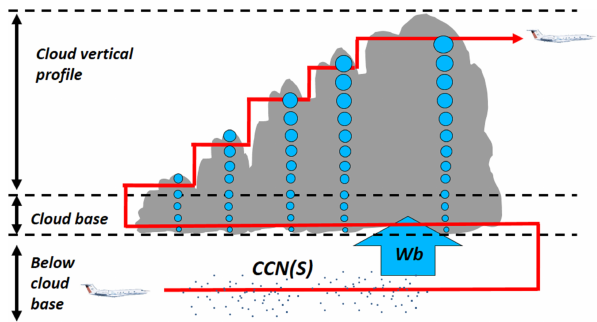
Figure 1. Flight patterns below and in convective clouds during the ACRIDICON–CHUVA